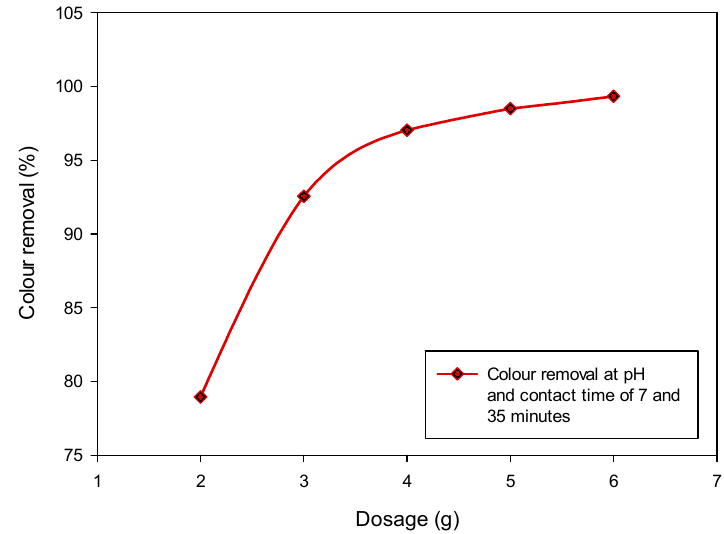
Figure 4. Colour removal from POME under variable sorbent dosage at fixed pH and contact time.